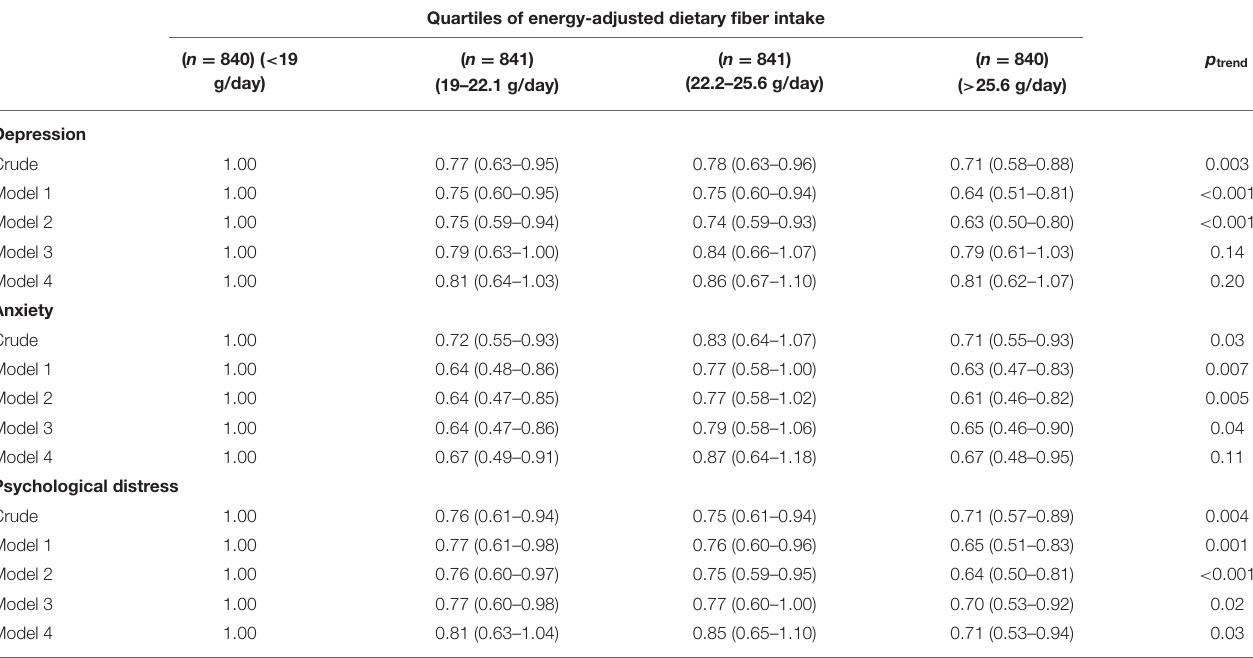
TABLE 3 | Multivariable-adjusted odds ratios and 95% confidence intervals for depression, anxiety, and psychological distress across quartiles of energy-adjusted dietary fiber intake in the whole population ( n = 3,362) a . Quartiles of energy-adjusted dietary fiber